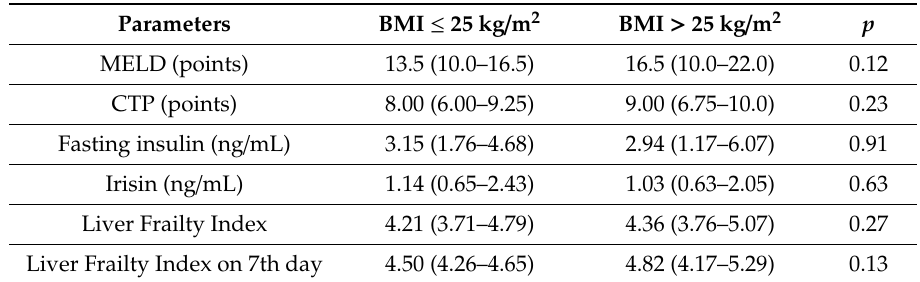
Table 11. Comparison of analyzed parameters between non-overweight and overweight